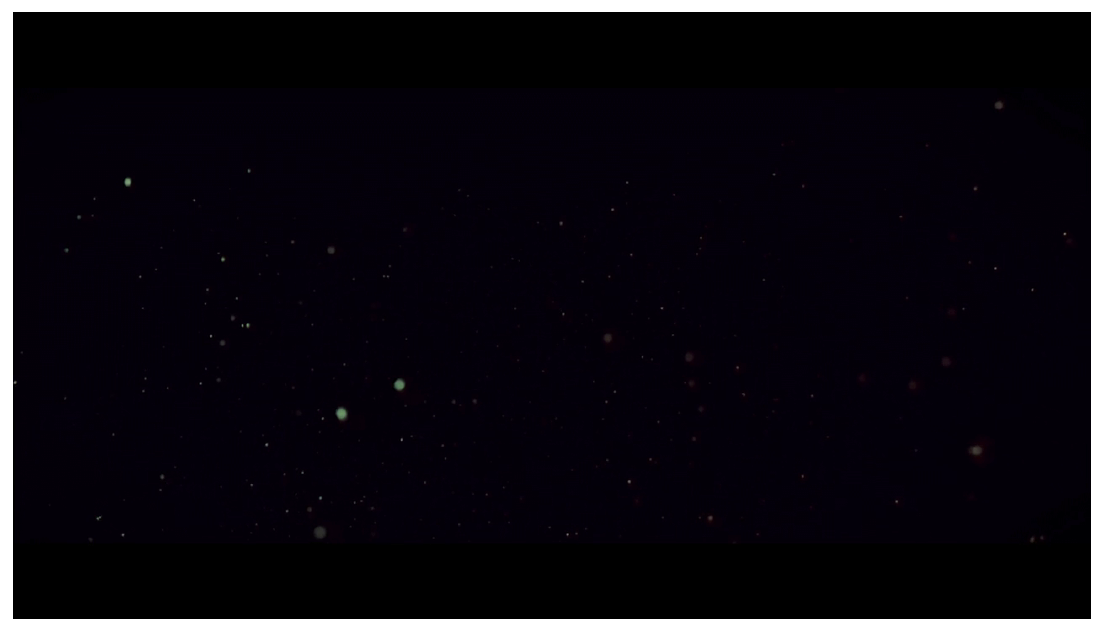
Figure 8. Injured and bedridden, Jack Crawford has a dream in which he relives Hannibal’s attack. Drops of his blood defy gravity and ascend to the sky, becoming white like stars (the reversal of the proper alchemical cycle from albedo to rubedo)— the camera pan first assumes Jack’s point of view and then tracks away from his body in an almost rotating fashion, as if the dead wife were “looking” at him from above. Screencap from Hannibal , season 3, episode 4, “Aperitivo,” directed by Marc